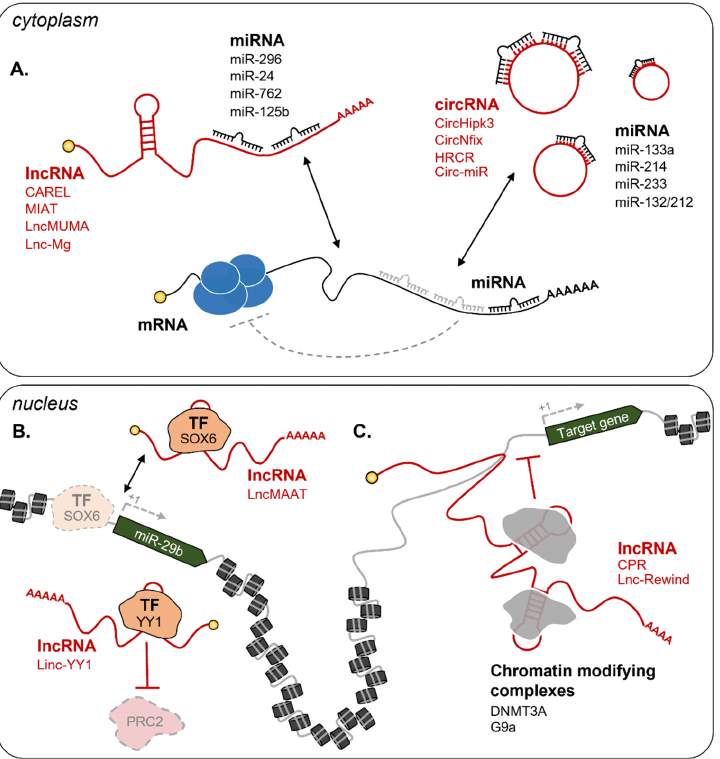
Figure 3. Examples of lncRNA circuitries in muscle regeneration. ( A ) In the cytoplasm, lncRNAs and circRNAs can act as competing endogenous RNAs (ceRNA) to interfere with miRNA binding to their targets. Examples include CAREL/mir-296 [161], MIAT/miR-24 [162], LncMUMA/miR-762 [163], Lnc-Mg/miR-125b [164], CircHipk3/miR-133a [165], CircNfix/miR-214 [166], HRCR/miR-233 [167], and Circ-miR/miR-132/212 [168]. In the nucleus, lncRNAs can influence gene expression at the epigenetic level through several mechanisms [65]. Examples in the figure include ( B ) lncRNA decoys: LncMAAT impedes SOX6 binding on the promoter of miR-29b to repress its transcription [169], Linc- YY1 binds YY1 and blocks its interaction with the PRC2 complex [170]; ( C ) lncRNA guides: CPR [171] and Lnc-Rewind [172] respectively interact with the DNMT3A and G9a repressive complexes and guide them on specific promoters. Dashed grey lines represent the loss of interaction and regulation. TF = Transcription Factor. See text for further